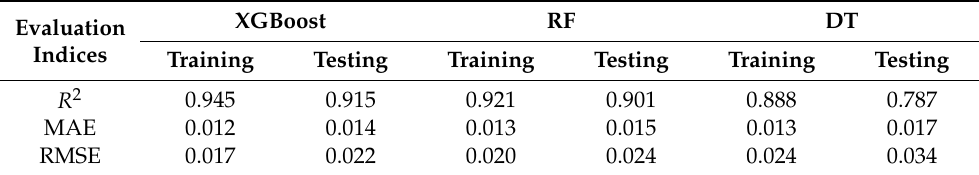
Table 3. Prediction results of three